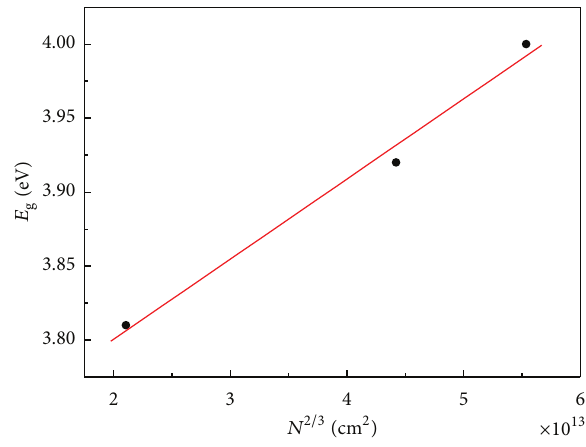
Figure 8: The relation between 𝐸 𝑔 and 𝑁 2/3 for ITO thin films.